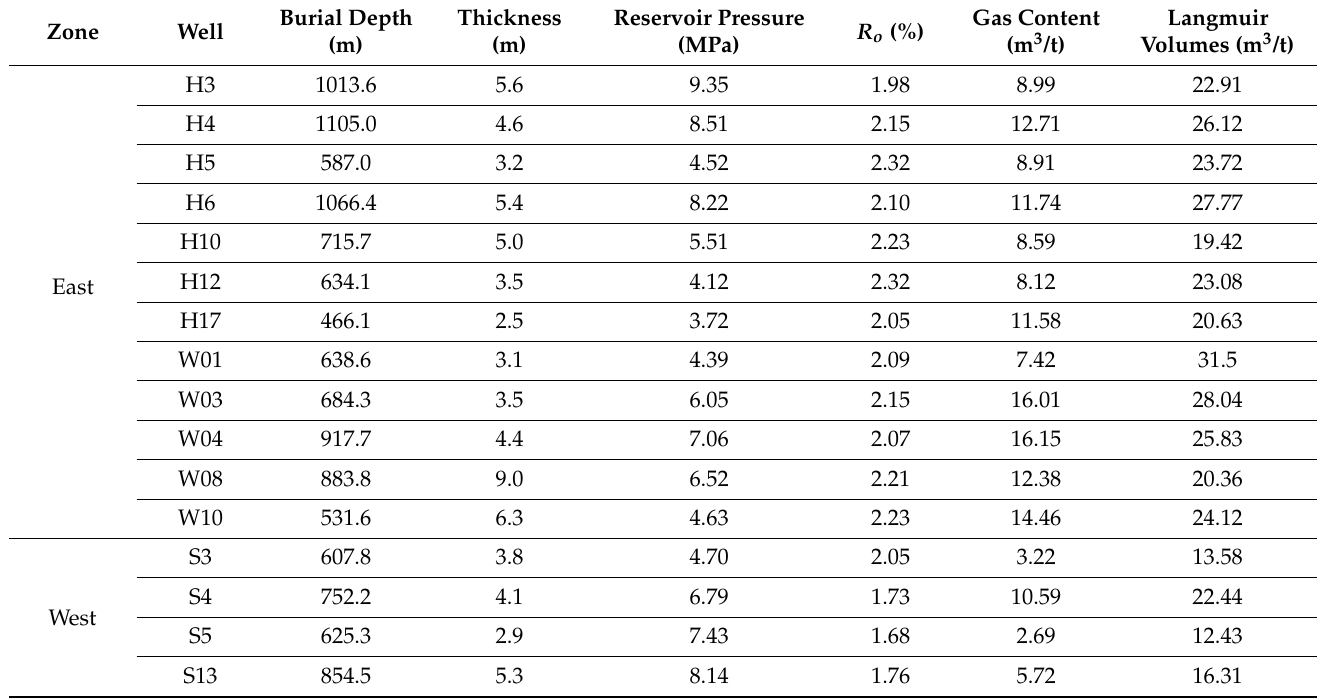
Table 1. Coal thickness, burial depth, reservoir pressure, and Langmuir volumes ( V L ) data of 16 coalbed methane (CBM) wells in the Weibei